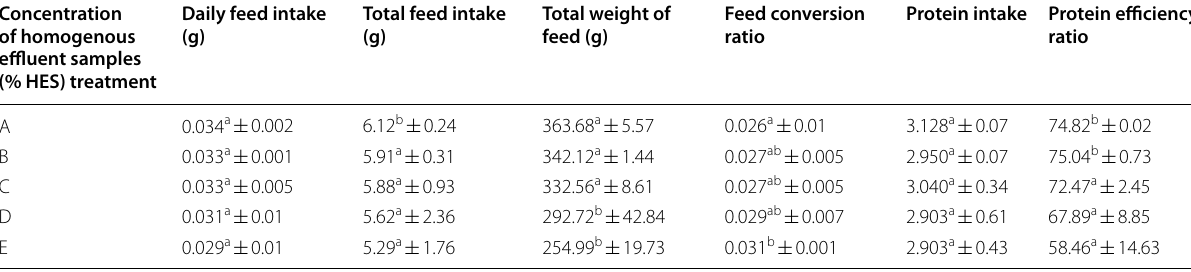
A—control; B—0.32%; C—0.66%; D—1.31%; E—2.63% *Values with different superscripts within the same column are significantly different at p < 0.05